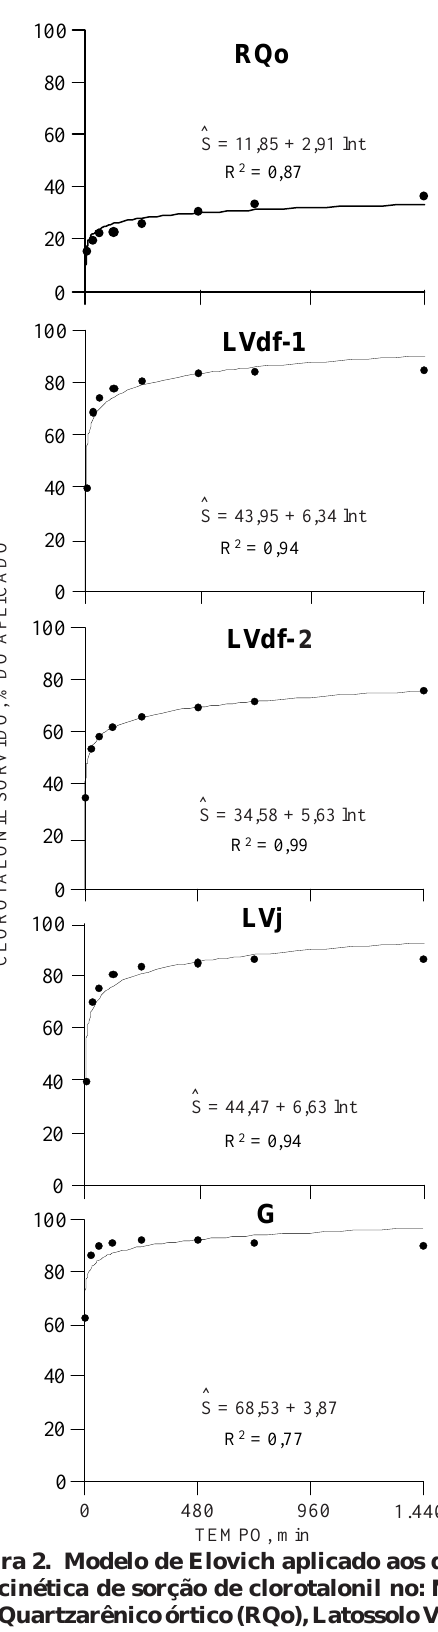
Figura 2. Modelo de Elovich aplicado aos dados de cinética de sorção de clorotalonil no: Neossolo Quartzarênico órtico (RQo), Latossolo Vermelho distroférrico (LVdf-1 e LVdf-2), Latossolo Vermelho perférrico (LVj) e Gleissolo